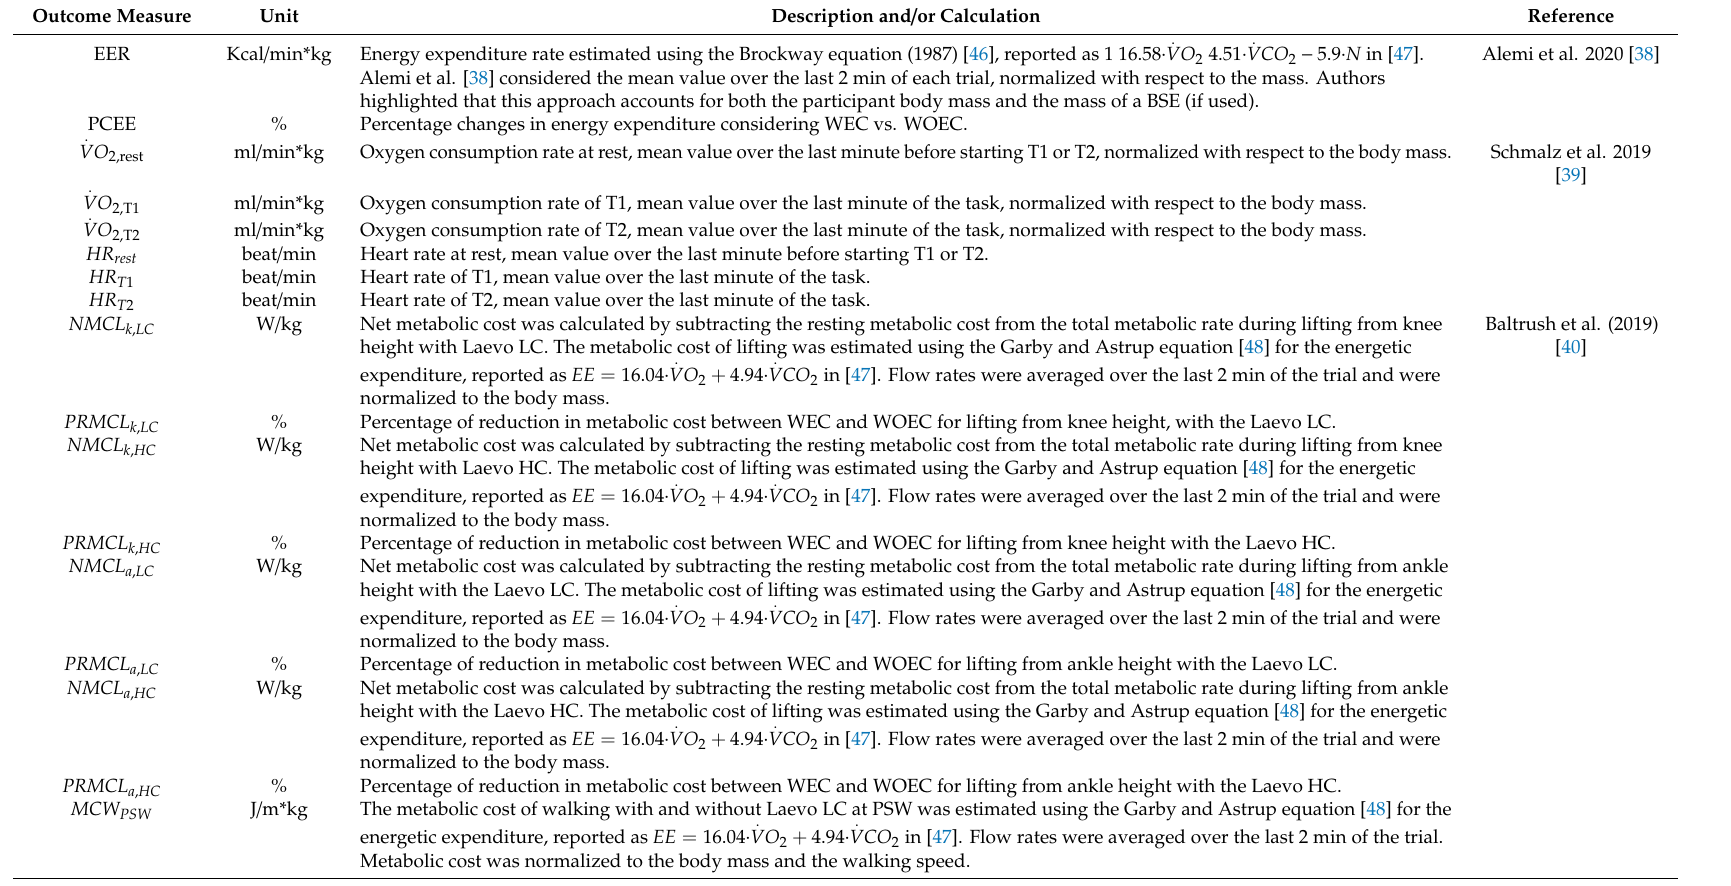
Table 2. Description of all the outcome parameters from the eligible